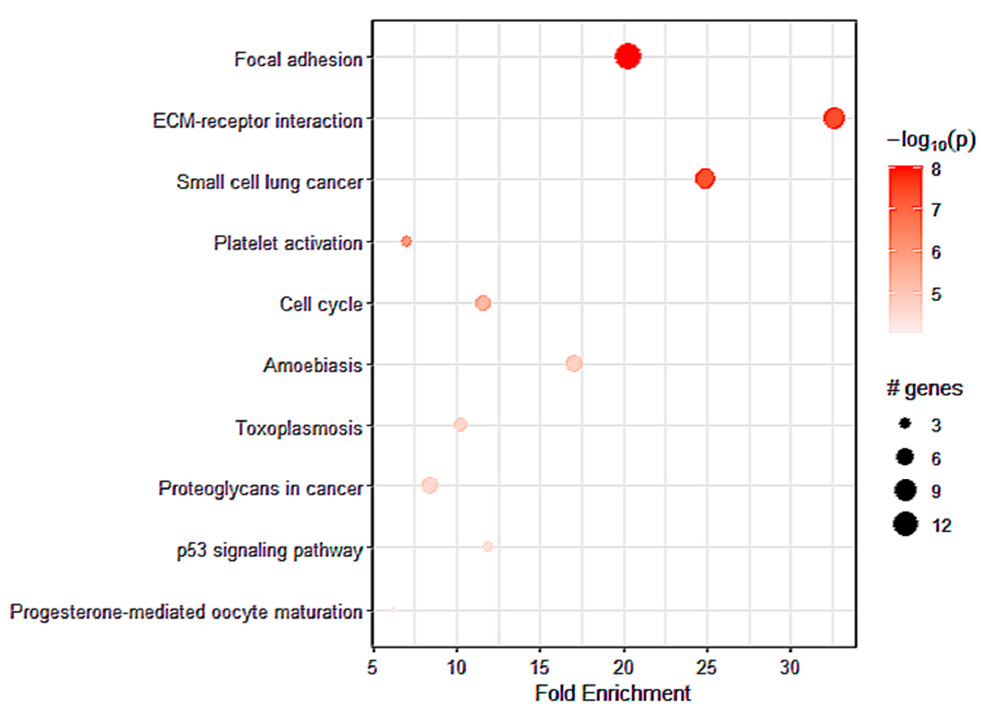
Figure 5. The top pathways for strong A 2A R expression obtained by KEGG enrichment in CGGA males. Table 4. The top pathways for strong A 2A R expression obtained by Hallmark enrichment in CGGA males.